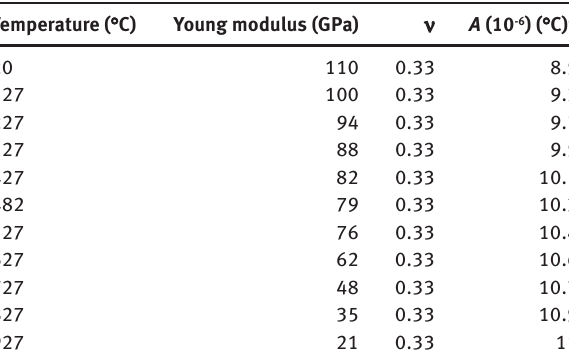
Table 1: Mechanical and thermal properties of Ti-6Al-4V [43]. Temperature ( ° C)